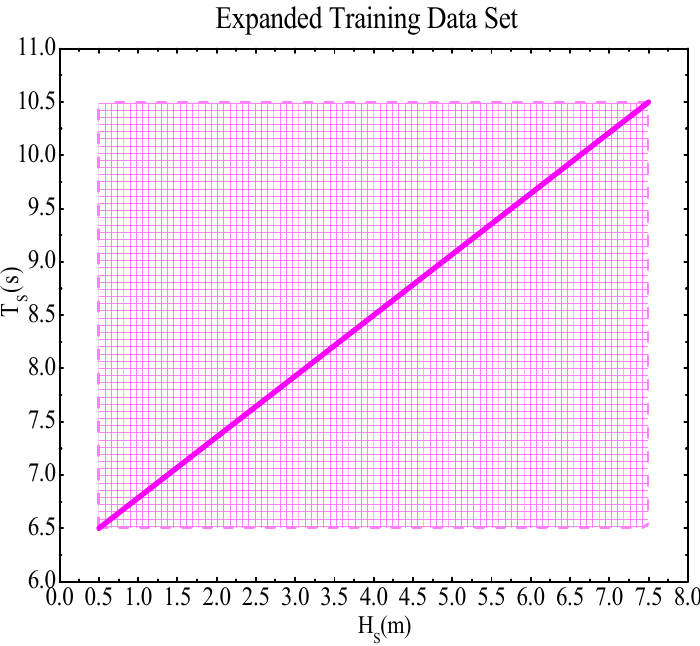
Figure 9. The range of parameter settings for the expanded training data set. H S means the significant wave height, and T S means the spectral peak period.